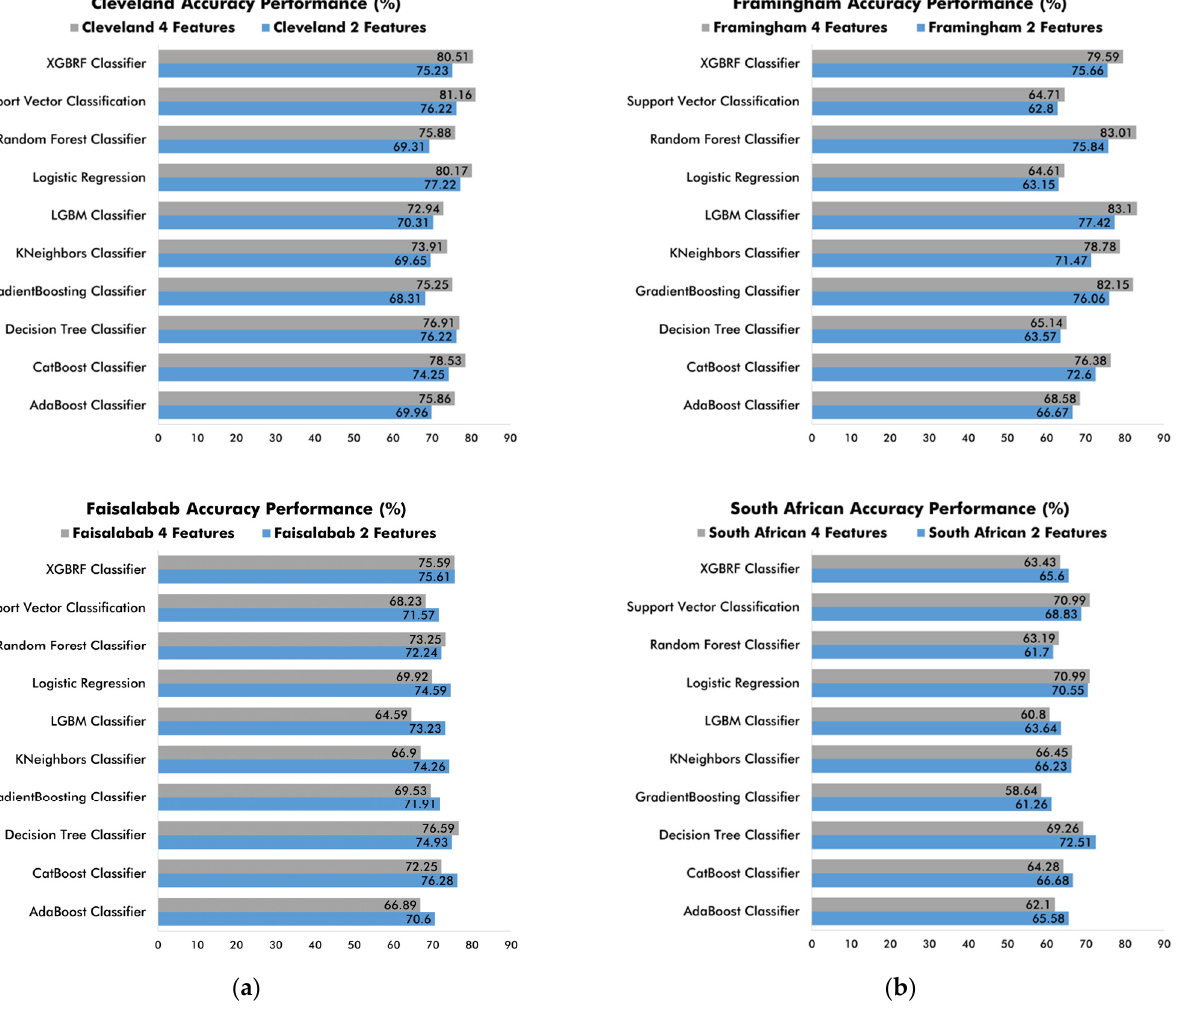
Figure 8. Comparison of ML classifier accuracy performance using k-fold cross-validation on top-two and top-four attributes from ( a ) medical diagnostic datasets; ( b ) medical prediction datasets.